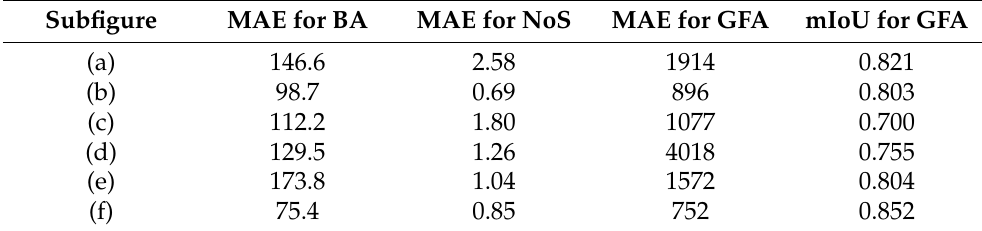
Table 6. Metrics of six test patches of MBB in mode A. The first/second column shows the MAE of BA/NoS estimation performance. The third/fourth column shows the MAE/mIoU of GFA estimation